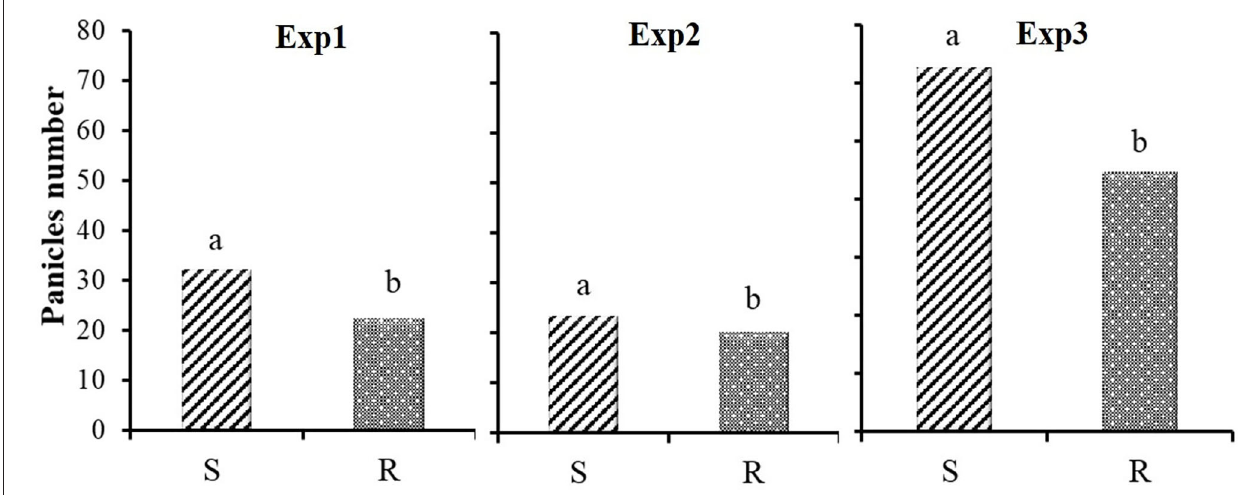
FIGURE 2 | Number of panicles registered at the final harvest for plants S and R in the three experiments. Different letters indicate significant differences ( P ≤ 0.05) separated by Fisher’s LSD test.